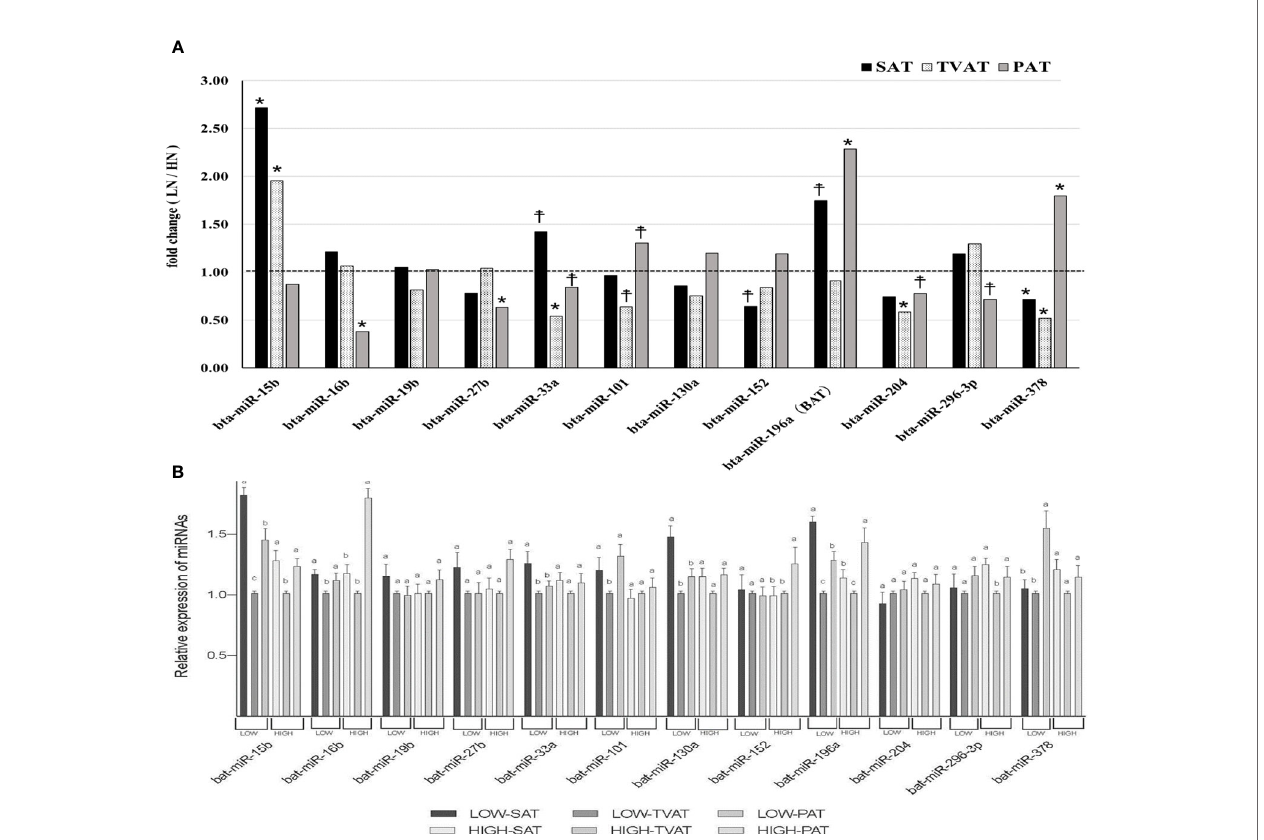
FIGURE 5 | Comparison of miRNAs in adipose tissues. (A) Comparison of fold change ( LOW/HIGH ) of miRNA abundance in subcutaneous (SAT), thoracic cavity visceral (TVAT), and perirenal adipose tissues (PAT) between LOW and HIGH fetuses in Wagyu cattle. The horizontal dotted line (at the value “ 1 ” ) showed the relative miRNA expression of the HIGH fetuses. The foldchange was calculated as the relative expression based on the mean of the target gene Ct value of LOW and HIGH fetuses. (B) Comparison of mRNA abundance between SAT, TVAT, and PAT in the LOW and the HIGH fetuses in Wagyu cattle. Fetus age: Fetuses: 260 ± 8.3 days of fetal age. LOW: n=6. HIGH: n=6. *Signi fi cant difference and ☨ trend ( p < 0.05 and p < 0.1, respectively) between LOW and HIGH fetuses. a,b,c Signi fi cant difference ( p < 0.05) between SAT, TVAT, and PAT in the LOW and the HIGH